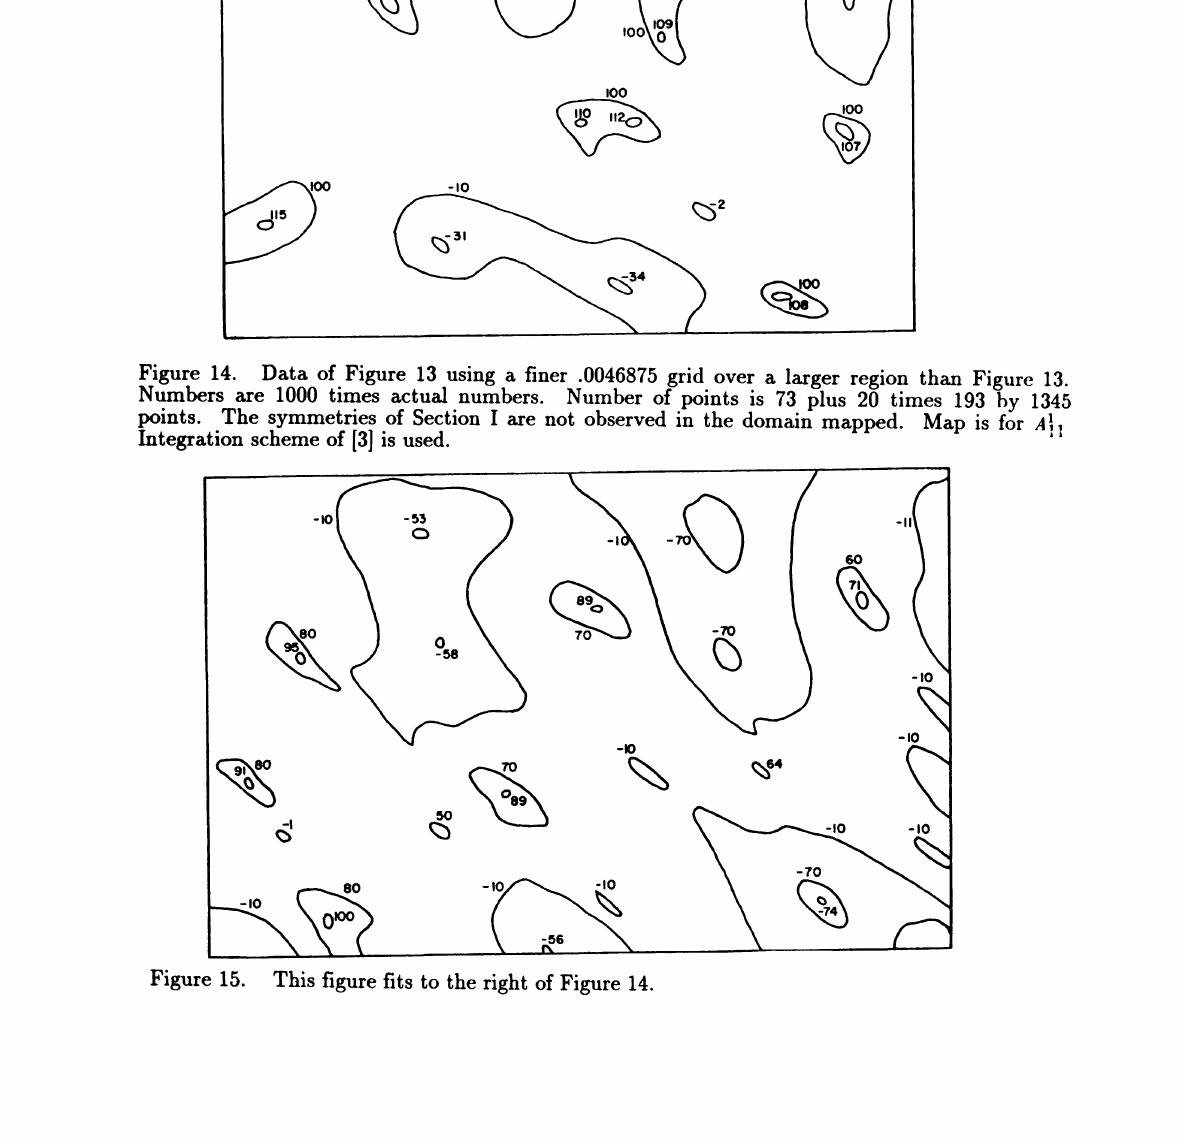
Figure 13. Data of Figure 12 using the integration scheme of [3]. The parameters of the are the same as Figures 3, 5, and 7. Number of points is 601 by 145. The grid is .028125. The numbers are 1000 times the actual numbers. Symmetry of Section is not observed. Map is for A}I.